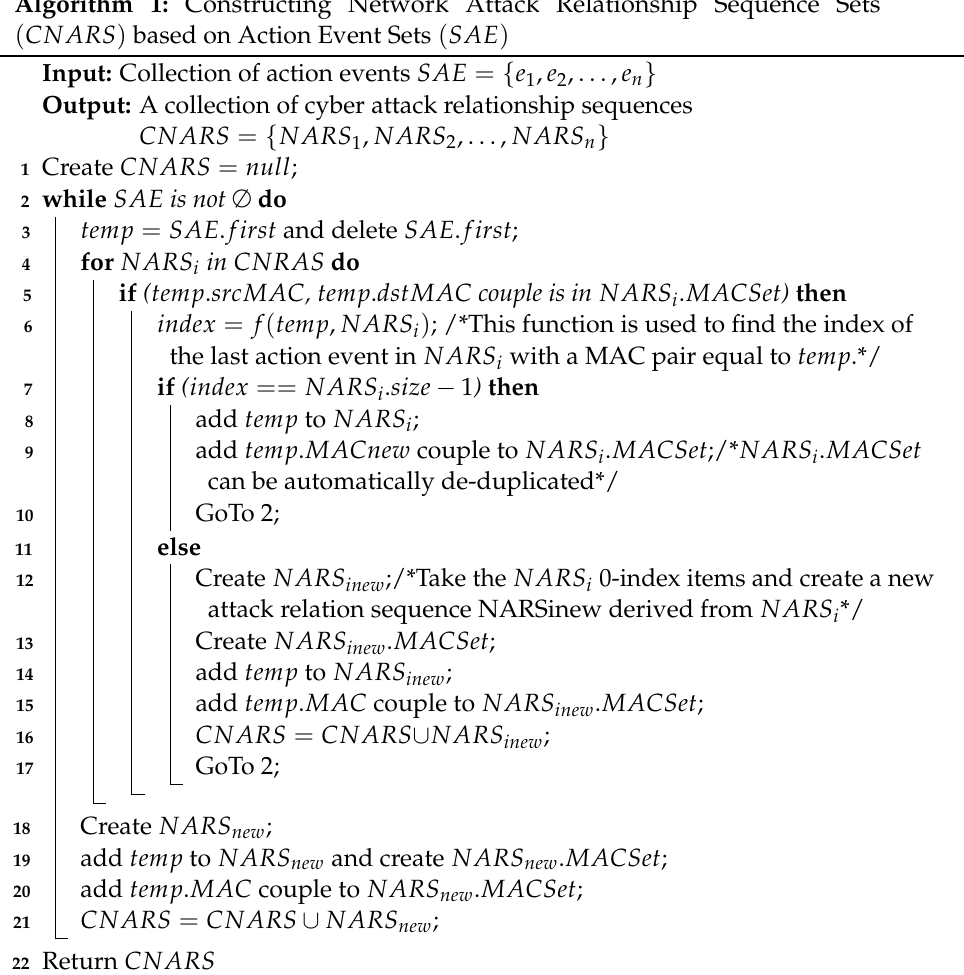
Algorithm 1: Constructing Network Attack Relationship Sequence Sets ( CNARS ) based on Action Event Sets ( SAE